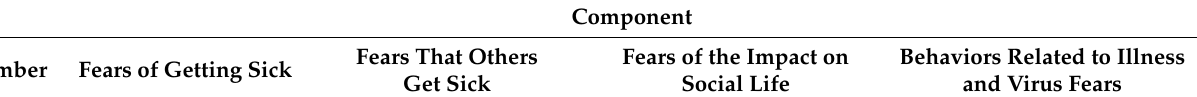
Table 5. Factor analysis for FIVE items 1–35.